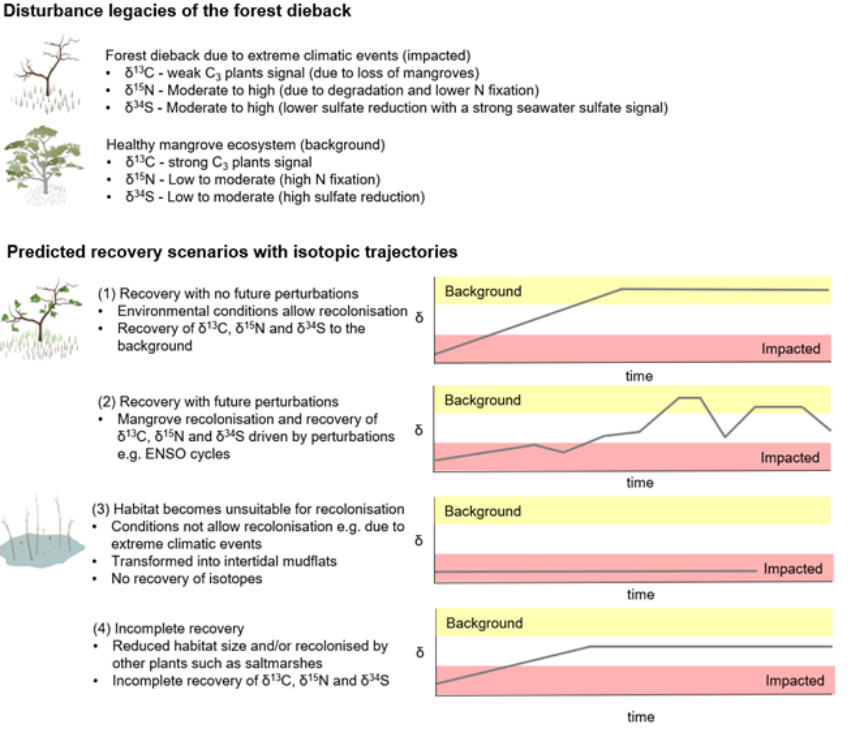
Figure 7. A conceptual diagram showing the ecological and biogeochemical legacy of the mangrove forest dieback in the Gulf of Carpentaria and four predicted recovery scenarios of the mangrove ecosystem with isotopic trajectories ( δ represents the isotope values of animals, plants and